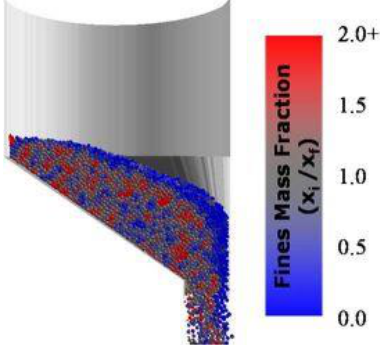
Figure 4. Segregation during discharge in an eccentric hopper, with the red color denoting the fine-rich fraction, and blue denoting the coarse fraction, according to discrete element modeling (DEM) by Ketterhagen et al., adapted with permission from [49]; published by Elsevier, 2010. In a more recent study, Zhang et al. used DEM to simulate percolation during dis- charge from a conical hopper of different angles (30° – 180°) for mixtures of higher size ratios than are usually explored (4 – 14.3). The emptying process could be divided into three stages: initial, in which fines dominated; transitory; and final, in which mostly large particles flowed out. It was found that at higher size ratios, segregation was more pro-